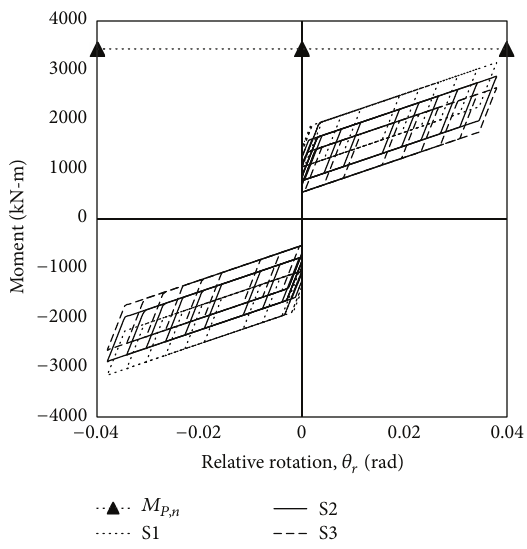
Figure 11: Moment-relative rotation response specimens S1, S2, and S3.